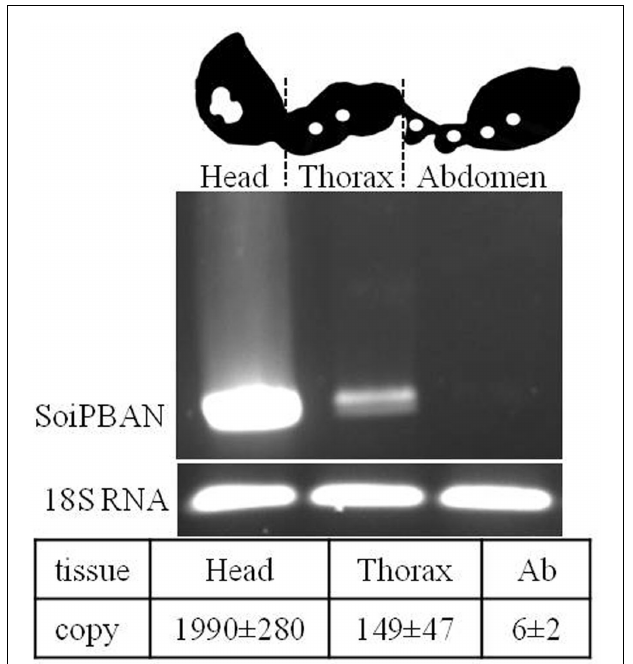
FIGURE 2 | Schematic drawing of fire ant tissues for SoiPBAN mRNA transcription levels analyzed by reverse transcription (RT) (upper) and quantitative (Q)-PCR (lower). Total RNAs from head, thorax, and abdomen (Ab) were amplified by RT-PCR and gene copies were quantified by Q-PCR. Gene copies per microgram RNA were significantly different ( t -test, P < 0.05, N = 3).The fire ant 18S rRNA gene is a positive control (Choi et al.,